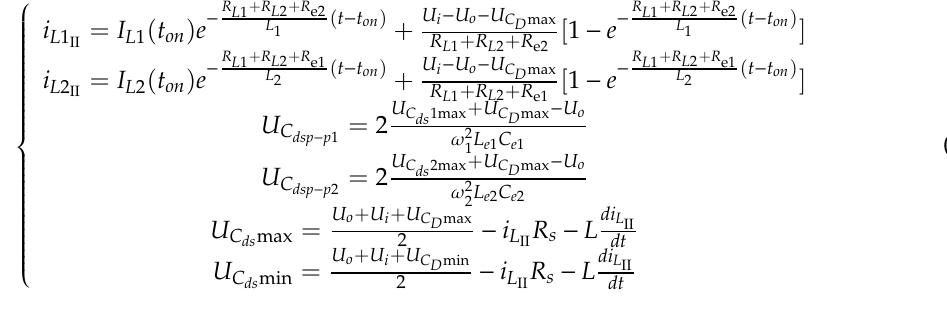
Figure 7. Equivalent circuit of Sneak Mode 1.